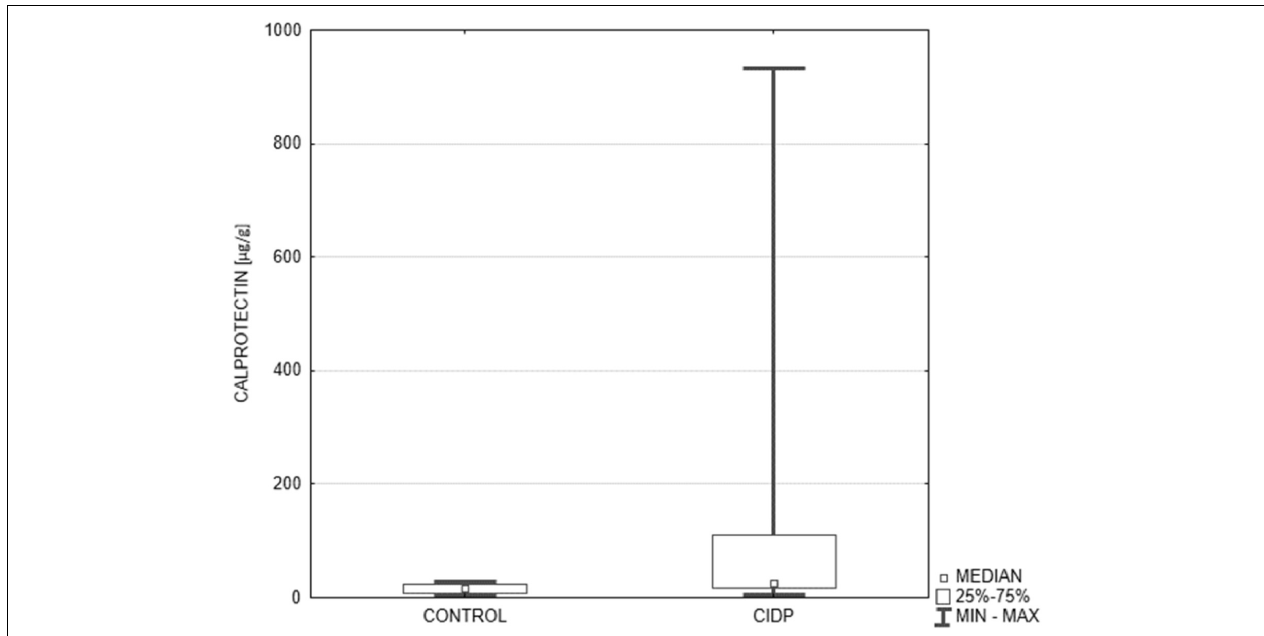
FIGURE 1 | Comparison of fecal calprotectin level in the control group and CIDP patients. Median fecal calprotectin level ( µ g/g) expressed as median along with the lower and upper quartiles was significantly higher in CIDP patients ( n = 15) compared to the controls ( n = 15): 26.6 [17.5–109.0] vs 15.6 [7.1–24.1], p = 0.0066. CIDP, chronic inflammatory demyelinating polyneuropathy (Mann-Whitney U